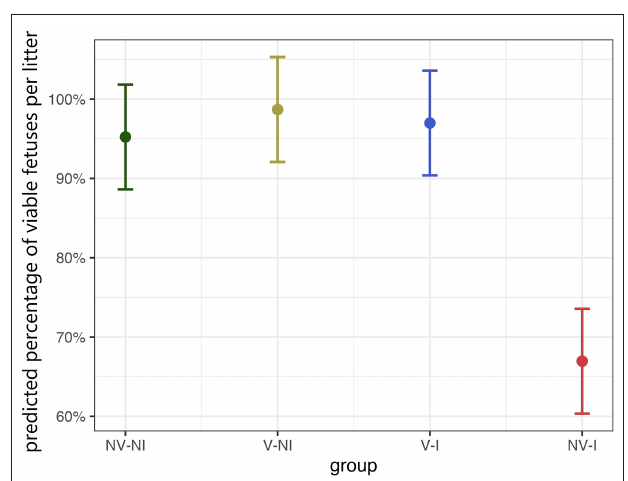
FIGURE 6 | Predicted values of the percentage of viable (VIA) fetuses per litter in relation to treatment group, calculated with a generalized linear mixed-effects logistic regression model. Fetal preservation status was dichotomized into two categories: VIA and non-VIA. The category VIA includes fetuses with physiologically white to purple skin color without meconium accumulation and physiological pulsing and bluish shimmering umbilical cord without visible edematous areas. The non-VIA category includes meconium-stained, decomposed, and autolyzed fetuses. The data points indicate the estimated marginal means of each group, and the error bars illustrate the respective confidence interval (confidence level of 95%). NV–NI, non-vaccinated and non-infected gilts; V–NI, vaccinated and non-infected gilts; V–I, vaccinated and infected gilts; NV–I, non-vaccinated and infected